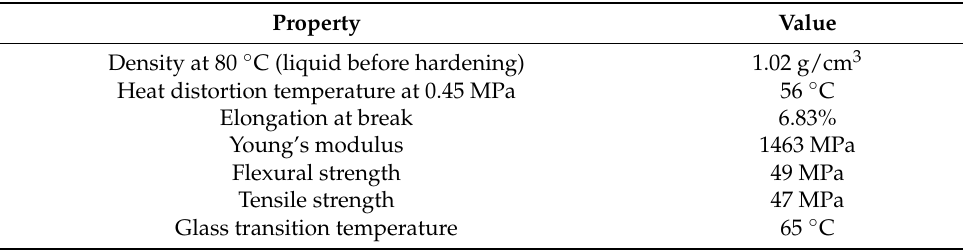
Table 2. Properties of the selected polymeric material—M3